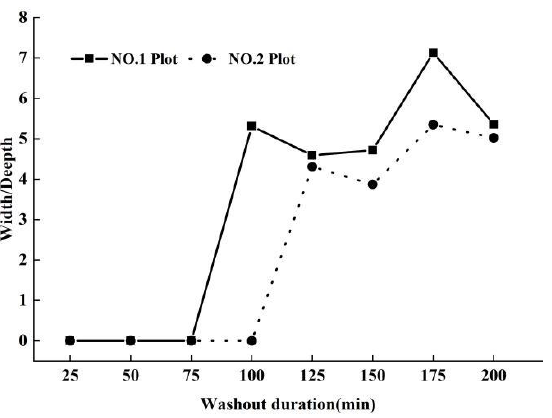
Figure 6. The dynamic changes in rill width/depth (W/D) with washout duration increasing, in short-term heavy rainfall (No. 1 plot) and moderate rainfall (No. 2 plot) experiments.